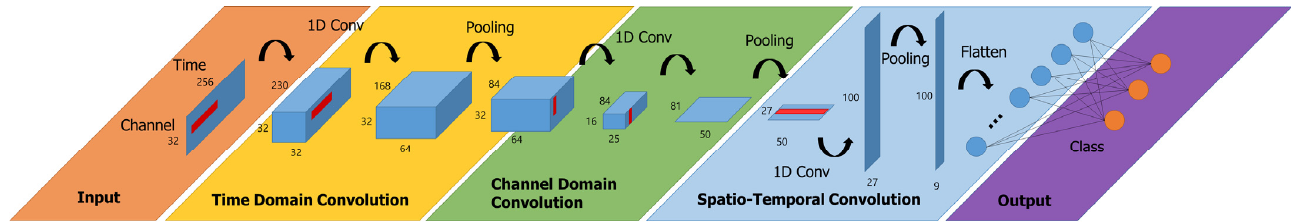
Figure 4. Schematic diagram of the proposed 1D convolution network for EEG